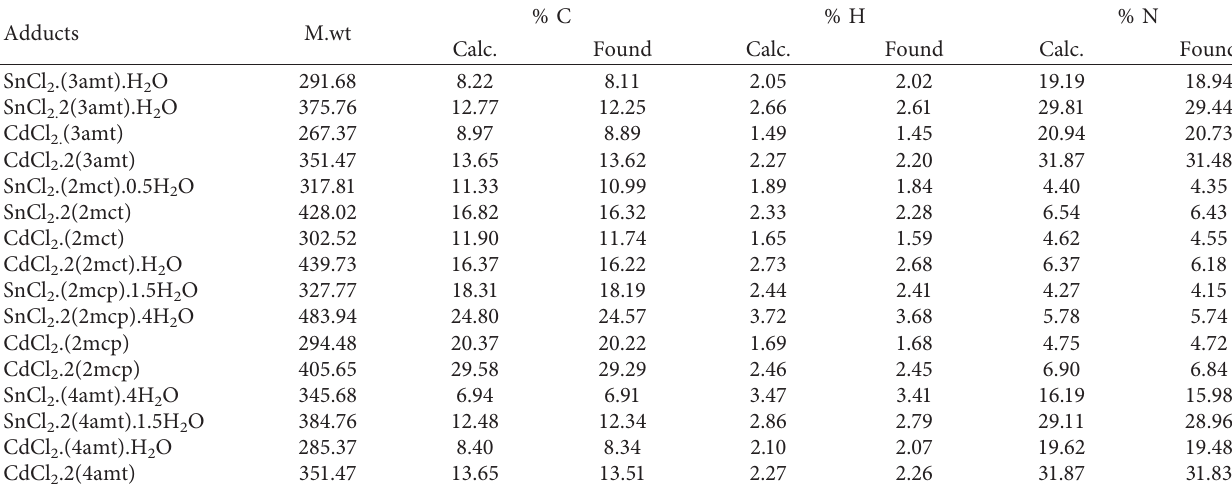
Table 1: Mass weight and carbon, hydrogen, and nitrogen elemental analysis data for the examined compounds. Adducts Found Calc. Found Calc. Found